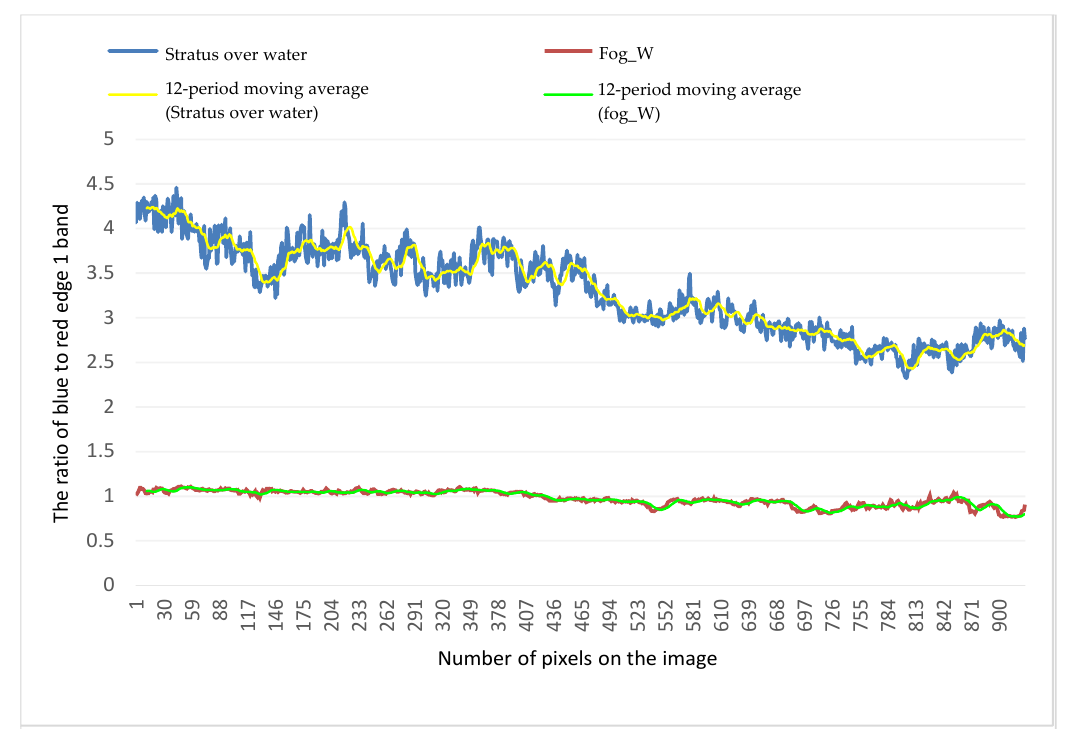
Figure 4. For GF-6 WFV data, the ratio of fog_W and stratus with high humidity over water in the blue band to the red edge position 1 band.